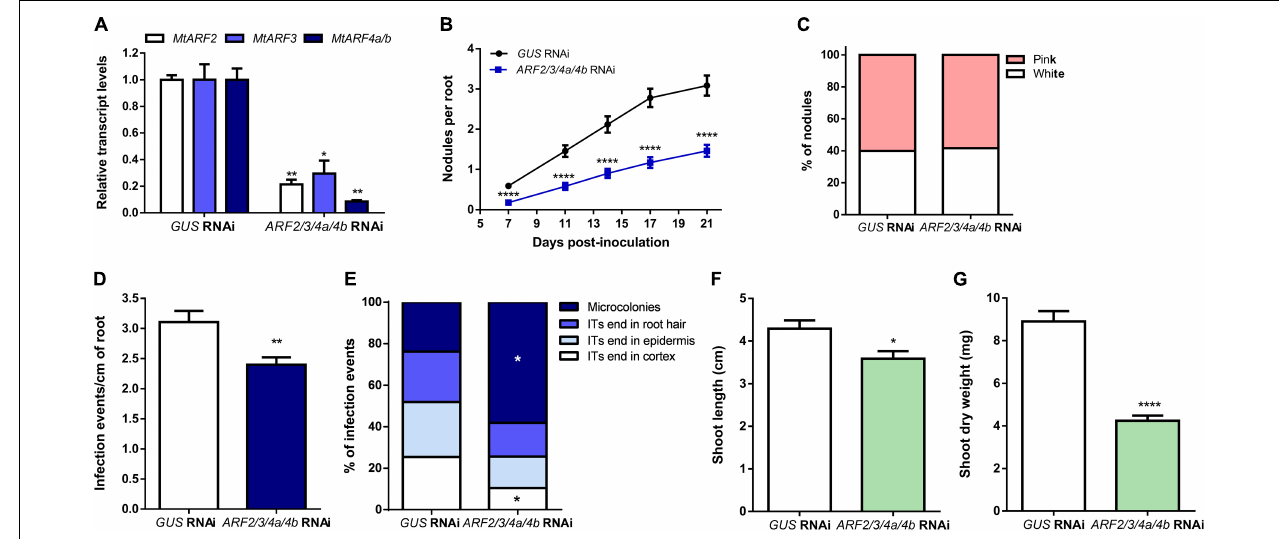
FIGURE 4 | Simultaneous knockdown of MtARF2, MtARF3, MtARF4a , and MtARF4b impaired nodule formation and infection by rhizobia. (A) Expression levels of MtARF2 , MtARF3 , and MtARF4a/b transcripts in GUS RNAi and ARF2/3/4a/4b RNAi roots. Expression values were determined by RT-qPCR, normalized to MtHIS3L , and expressed relative to the GUS RNAi sample, which was set at 1. Each bar represents the mean ± SE of three biological replicates (whole root tissue from at least three composite plants were collected in each biological replicate) with three technical replicates each. Asterisks indicate statistically significant differences between GUS and ARF2/3/4a/4b RNAi roots in an unpaired two-tailed Student’s t test ( ∗ p ≤ 0.05, ∗∗ p ≤ 0.01). (B) Time-course nodule formation in GUS and ARF2/3/4a/4b RNAi roots upon inoculation with S. meliloti . Error bars represent mean ± SE of three independent biological replicates, each with at least 50 roots. Four asterisks indicate statistically significant differences between GUS and ARF2/3/4a/4b RNAi roots in an unpaired two-tailed Student’s t test with a p value ≤ 0.0001. (C) Percentage of pink and white nodules developed in GUS RNAi and ARF2/3/4a/4b RNAi roots at 21 dpi. Bars represent the mean ± SE of three independent biological replicates. More than 68 nodules from more than 15 independent plants per construct were quantified in each biological replicate. (D) Density of infection events in GUS and ARF2/3/4a/4b RNAi roots at 7dpi with a S. meliloti strain expressing the RFP protein. Each bar represents the mean ± SE of three biological replicates, each with more than 25 transgenic roots. The asterisks indicate statistically significant differences between GUS and ARF2/3/4a/4b RNAi roots in an unpaired two-tailed Student’s t test with a p value ≤ 0.01. (E) Progression of infection events in GUS and ARF2/3/4a/4b RNAi roots. Infection events were classified as microcolonies, infection threads (ITs) that end in the root hair, in the epidermal cell layer, or reach the cortex at 7 dpi. Each category is presented as the percentage of total infection events. Data are representative of three independent biological replicates, each with more than 25 transgenic roots. The asterisk indicates that the percentage of microcolonies and ITs that end in cortex was significant different between GUS and ARF2/3/4a/4b RNAi roots in an unpaired two-tailed Student’s t test with a p value ≤ 0.05. (F,G) Shoot length (F) and shoot dry weight (G) measured in GUS and ARF2/3/4a/4b RNAi composite plants grown on free-nitrogen slanted agar-Fahraeus at 21 dpi with S. meliloti . Error bars represent the mean ± SE of three biological replicates, each performed with more than 10 composite plants. Asterisks denote a statistically significant difference between GUS and ARF2/3/4a/4b RNAi composite plants in an unpaired